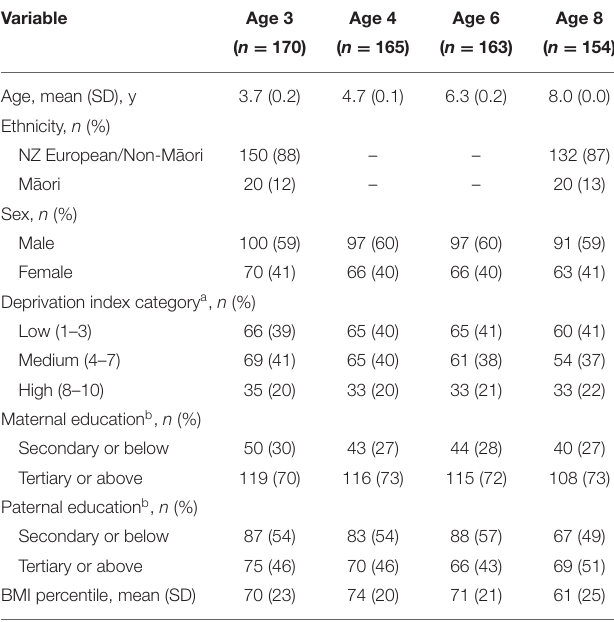
TABLE 1 | Descriptive statistics for demographic characteristics and BMI percentile at each time point.